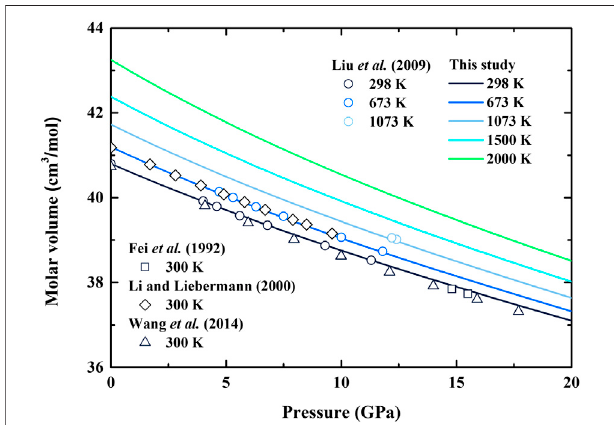
FIGURE 1 | Molar volume of Fe-bearing wadsleyite as a function of pressure at various temperatures. Solid lines: calculated result of β - (Mg 0.87 Fe 0.13 ) 2 SiO 4 from this study; Circles: X-ray diffraction measurement of β -(Mg 0.87 Fe 0.13 ) 2 SiO 4 at various temperatures by Liu et al. (2009); Squares: X-ray diffraction measurement of β -(Mg 0.84 Fe 0.16 ) 2 SiO 4 at 300 K by Fei et al. (1992); Diamonds: result of β -(Mg 0.88 Fe 0.12 ) 2 SiO 4 obtained from ultrasonic experiment at 300 K by Li and Liebermann (2000); Triangles: result of β -(Mg 0.925 Fe 0.075 ) 2 SiO 4 obtained from Brillouin scattering experiment by Wang et al.